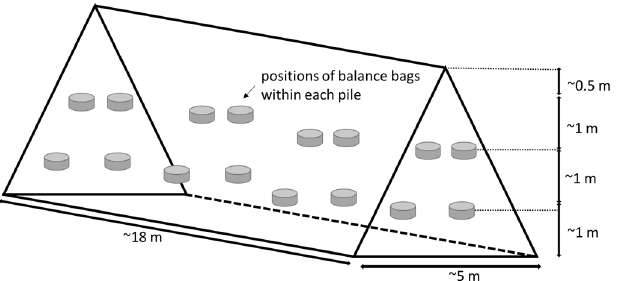
Figure 4. Schematic sketch of a pile in the experiment, indicating the approximate positions of balance bags within the chip piles.